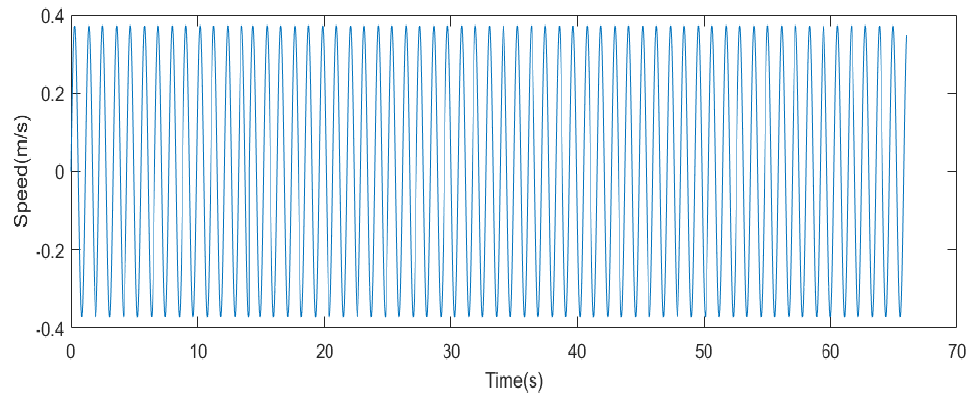
Figure 10. Fluctuation of flap speed.